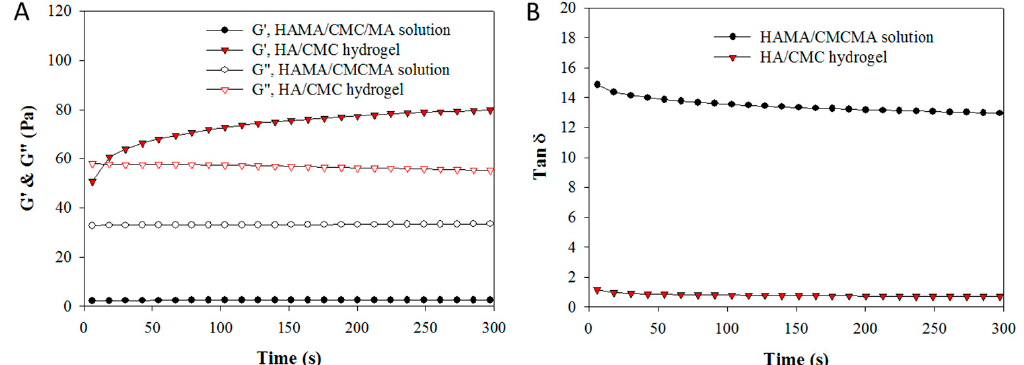
Figure 2. The storage modulus (G ′ ) and loss modulus (G ″ ) ( A ) and the loss tangent (tan δ ) ( B ) of HAMA/CMCMA solution (1/3 mass ratio) and HA/CMC (HC13) hydrogel after photo-crosslinking.